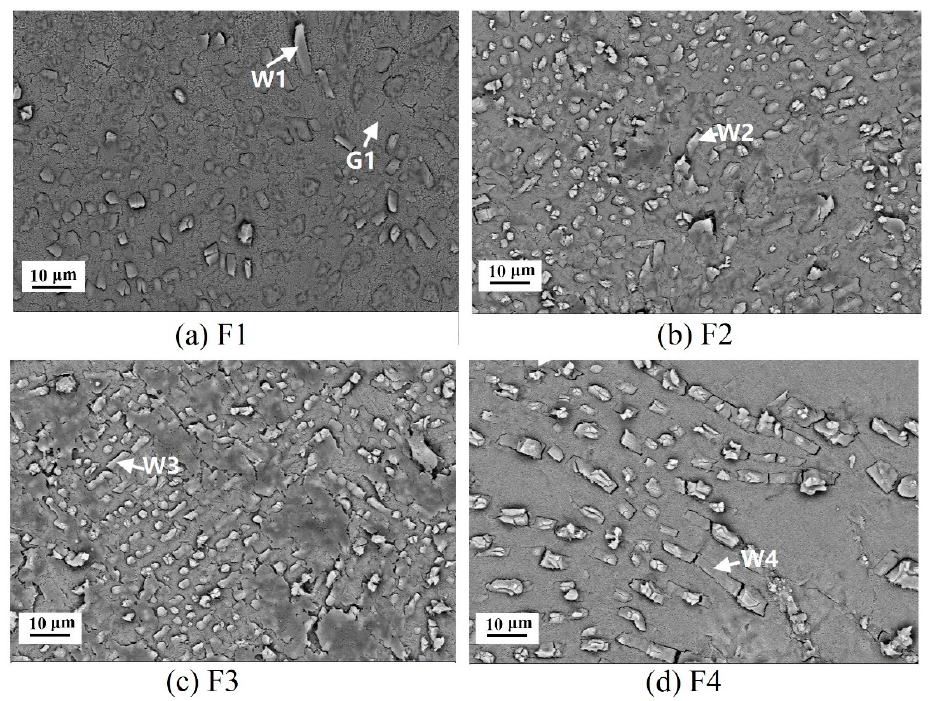
Figure 6. The microstructure images of wollastonite glass-ceramics with different CaF 2 addition obtained by heat treatment at 1120 ° C. ( a ): sample F1; ( b ): sample F2; ( c ): sample F3; ( d ): sample F4. Table 3. Semiquantitative energy spectrum analysis of the selected phases shown in Figure 6. Spot No.